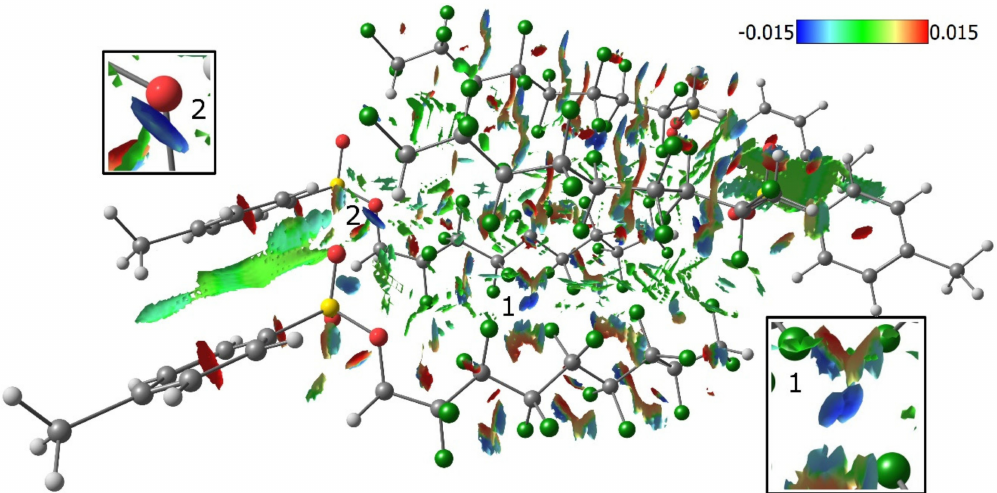
Figure 12. 3D surface of RDG (0.6 a.u.) colored according to sign ( λ 2 ) ρ function in 4 illustrating the interactions between (CF 2 ) 5 CHF 2 groups. Intermolecular C-H ... O bond (1) and strong F ... F interaction (2) are